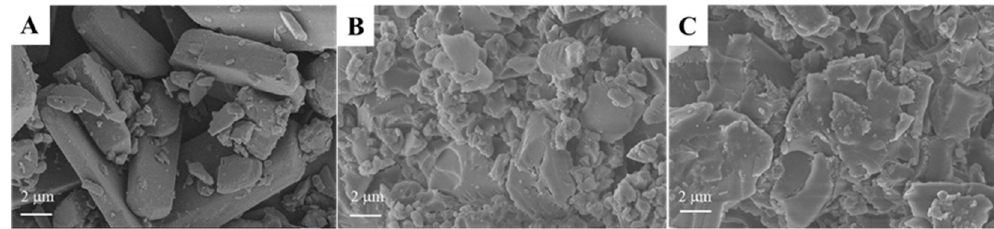
Figure 4. SEM images of ( A ) DPG, ( B ) β -CDP, and ( C ) DPG- β -CDP.